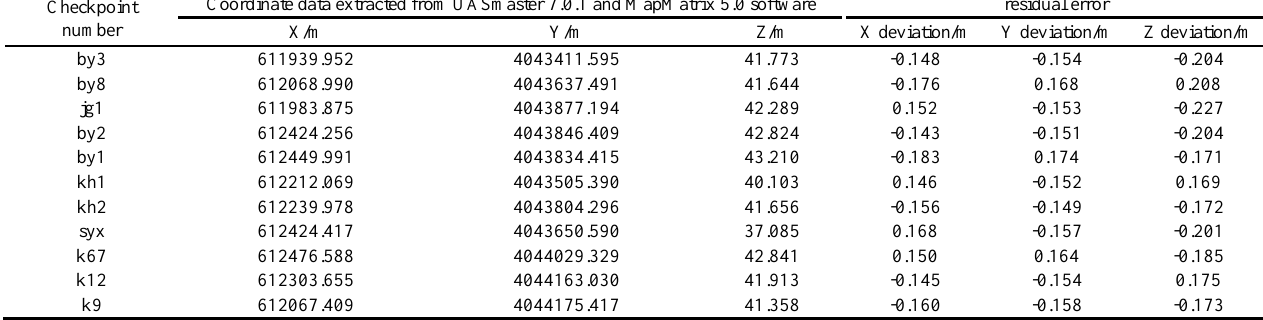
Table 9. Scheme Ⅳ experimental data